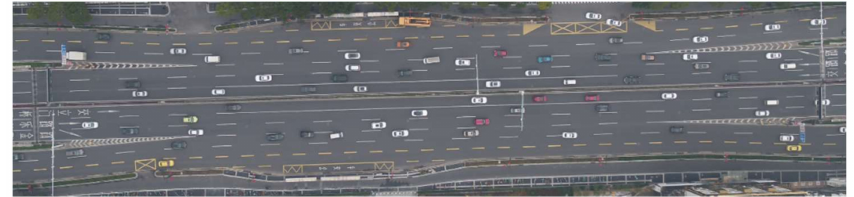
Figure 3. Aerial view of the urban expressway at a weaving section.